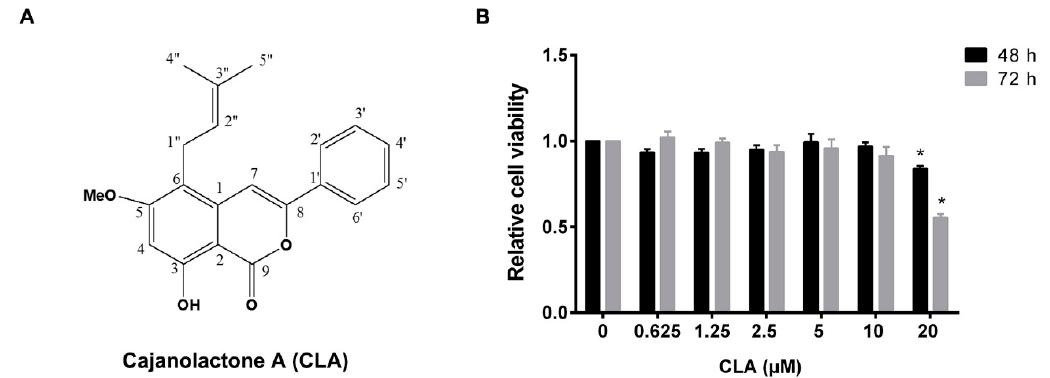
Figure 1. Effect of cajanolactone A (CLA) on proliferation of human bone marrow mesenchymal stem cells (hBMSCs). ( A ) Structure of CLA. ( B ) Relative viability of hBMSCs treated with various concentrations of CLA for 48 or 72 h. Data are expressed as mean ± SD ( n = 3). Compared to control (0 µ M), data were significantly different at * p < 0.05.